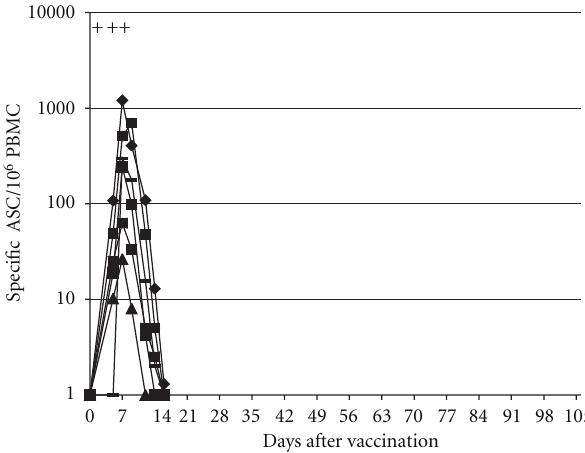
Figure 1: Numbers of vaccine antigen (O9,12)-specific circulating plasmablasts identified as antibody-secreting cells/10 6 PBMC (IgA- + IgG- + IgM) in six volunteers vaccinated with the live oral Salmonella typhi Ty21a vaccine. Each volunteer received one vaccine dose on days 0, 2, and 4 (the vaccination days are indicated with “+”). To determine the kinetics of the response, the numbers of plasmablasts were determined on several days for as long as ASCs were found in the samples. The values of each individual are connected with a